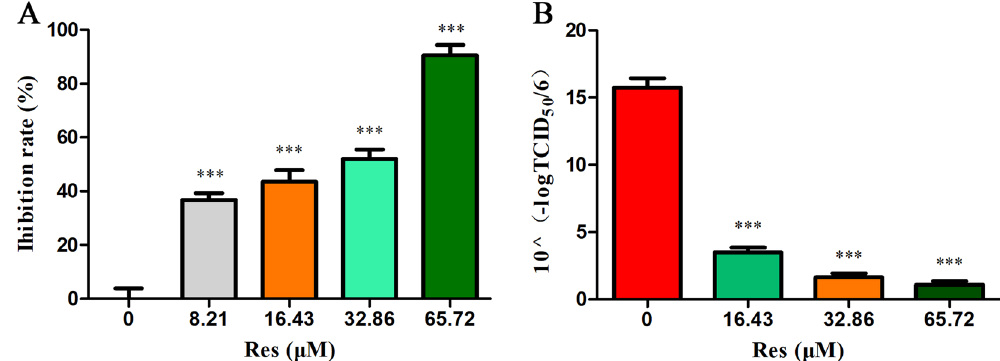
Figure 1. Antiviral activity of Res. The inhibition rate of Res on infection with PRV ( A ): PK-15 cells were first infected with PRV (100TCID 50 ) and then treated with Res. After incubation for 48 h, a CCK-8 assay was performed, and the results were expressed as percent of inhibition in drug-treated cultures compared with the untreated group. Viral titres of PRV at growing conditions with different concentrations of Res ( B ): PK-15 cells were infected with PRV (100TCID 50 ) and then treated with Res. After incubation for 48 h, the supernatants were collected and analysed for TCID 50 values. Values are means ± SD (n = 6). Correlation analyses were evaluated by Pearson r2, ns: p > 0.05, * p < 0.05, ** p < 0.01, and *** p < 0.001 vs. PRV-infected cells.